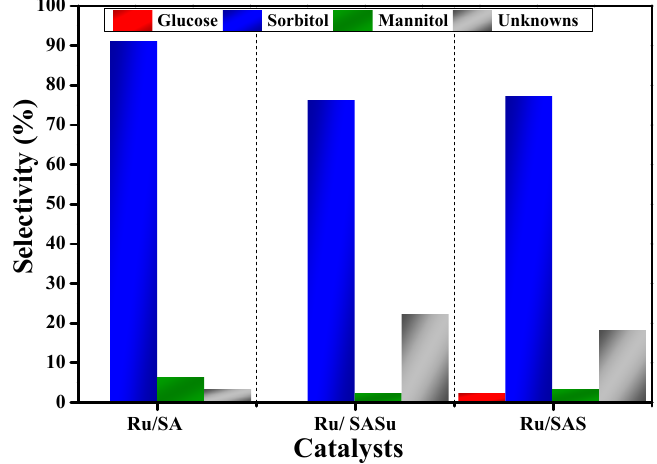
Figure 7. Selectivity data of the three studied catalysts.